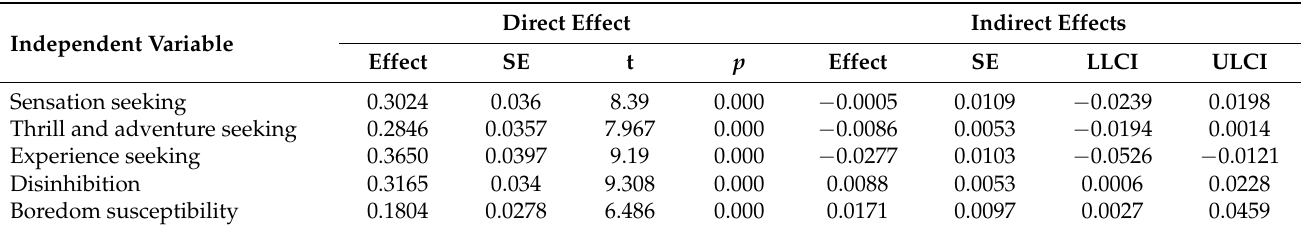
Table 5. Mediating effect of loneliness on predicting excessive internet use.